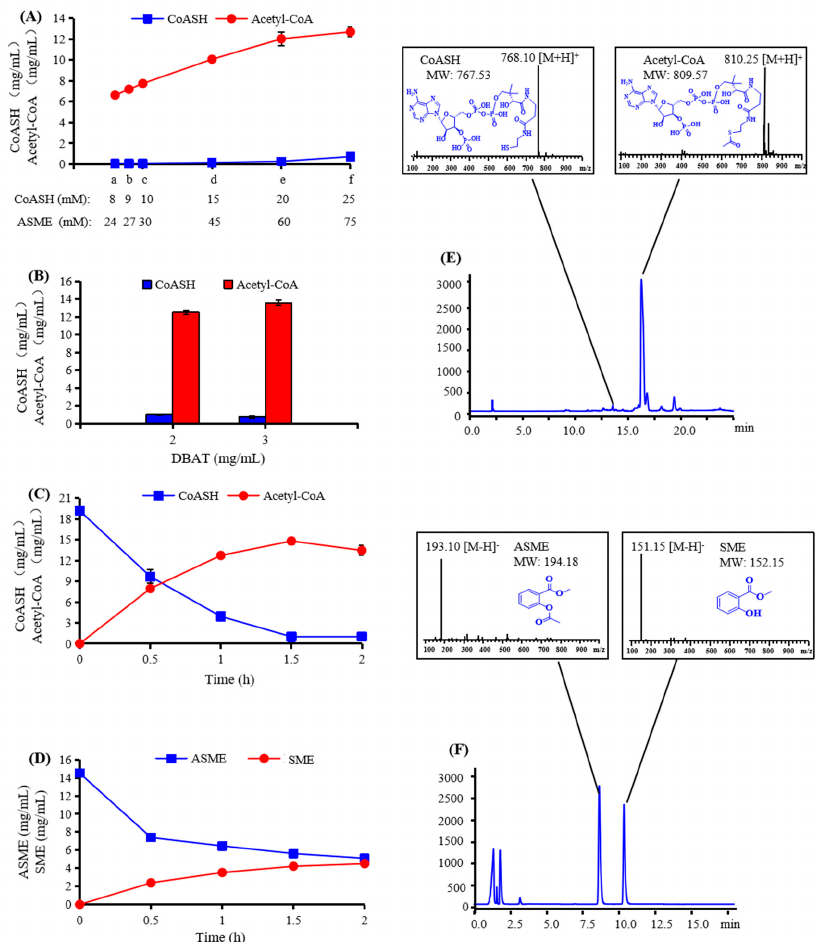
Figure 4. Re-optimization by increasing the concentrations of CoASH/ASME and DBAT. ( A ) Increasing the concentrations of CoASH/ASME for the production of acetyl-CoA. The molar ratio of CoASH/ASME was defined as 1/3 (KH 2 PO 4 /K 2 HPO 4 •3H 2 O = 1.7 mM/7.2 mM, DBAT = 2 mg/mL, at 37 °C, pH7.0). ( B ) The influence of different DBAT concentrations on the production of acetyl-CoA, (CoASH/ASME = 25 mM/75 mM, KH 2 PO 4 /K 2 HPO 4 •3H 2 O = 1.7 mM/7.2 mM, at 37 °C, pH7.0). ( C ) The time-production curve of acetyl-CoA based on the HPLC analysis, (CoASH/ASME = 25 mM/75 mM, KH 2 PO 4 /K 2 HPO 4 •3H 2 O = 1.7 mM/7.2 mM, DBAT = 3 mg/mL, at 37 °C, pH7.0). ( D ) The time-production curve of SME based on the HPLC analysis (CoASH/ASME = 25 mM/75 mM, KH 2 PO 4 /K 2 HPO 4 •3H 2 O = 1.7 mM/7.2 mM, DBAT = 3 mg/mL,